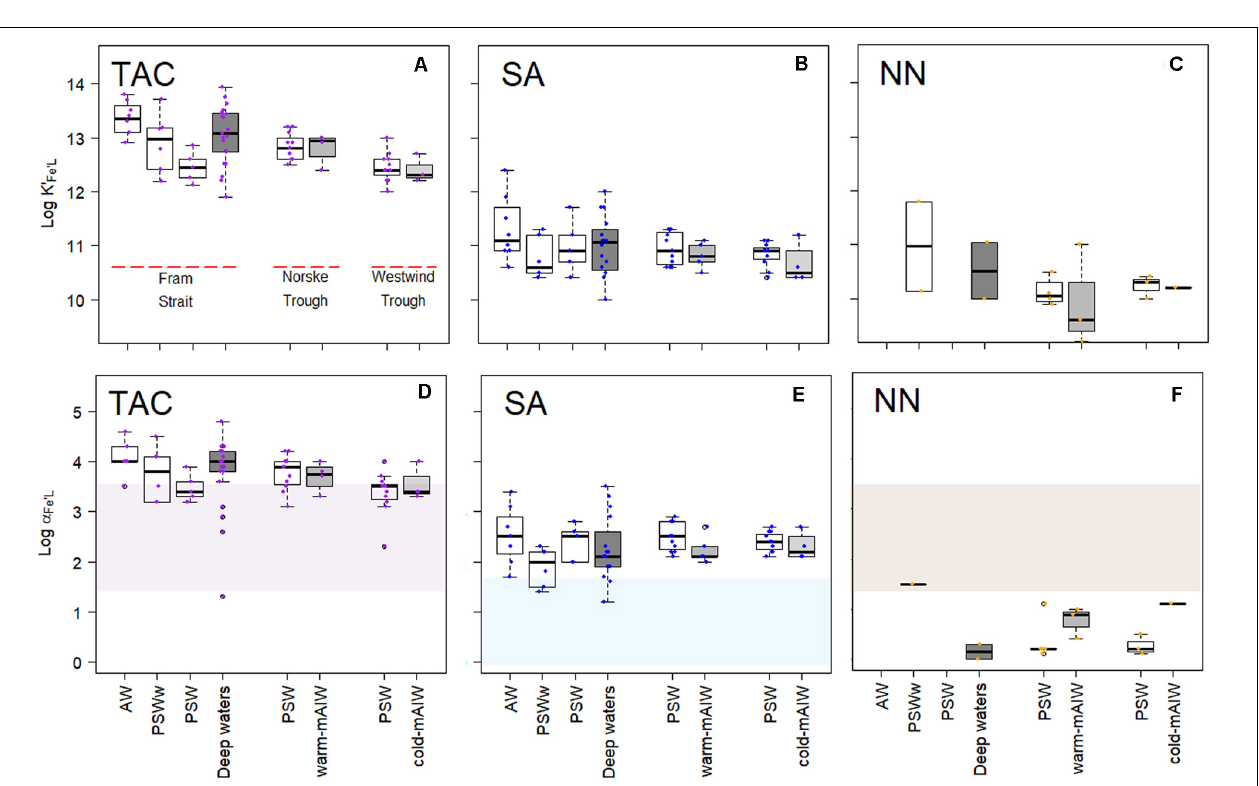
FIGURE 3 | Boxplot showing the difference in ligand concentrations obtained by TAC, SA and NN, [L t ] TAC , [L t ] SA and [L t ] NN , respectively. (A) the absolute difference in concentrations [L